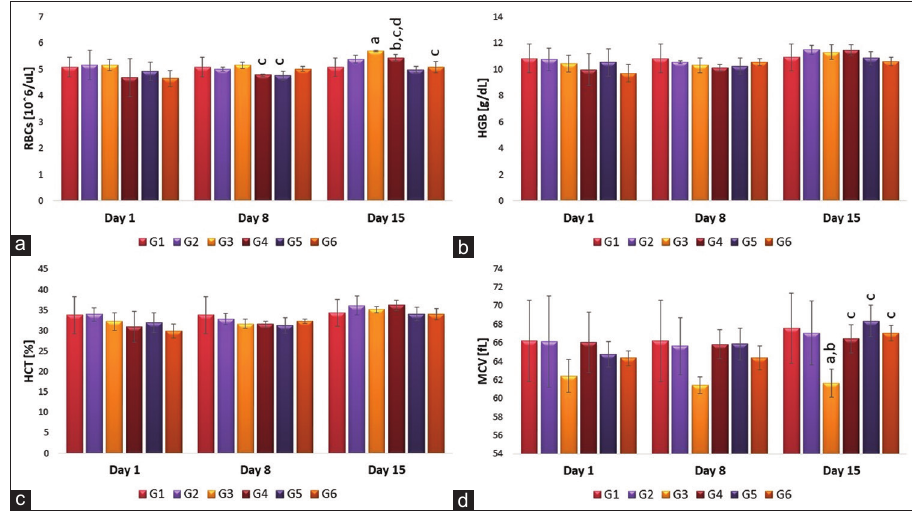
Figure-6: (a-d) Effects of single and repeated intravenous injection of 300 μ g/kg body weight 50 nm either gold nanosphere or gold nanorods in male rabbits on red blood cells, hemoglobin, hematocrit, and mean corpuscular volume on days 1, 8, and 15 post-treatment. Means carrying superscripts are significantly different at p<0.05 based on Tukey’s honestly significant difference. a=Significantly different versus G1, b=Significantly different versus G2, c=Significantly different versus G3, d=Significantly different versus G4, and e=Significantly different versus G5.